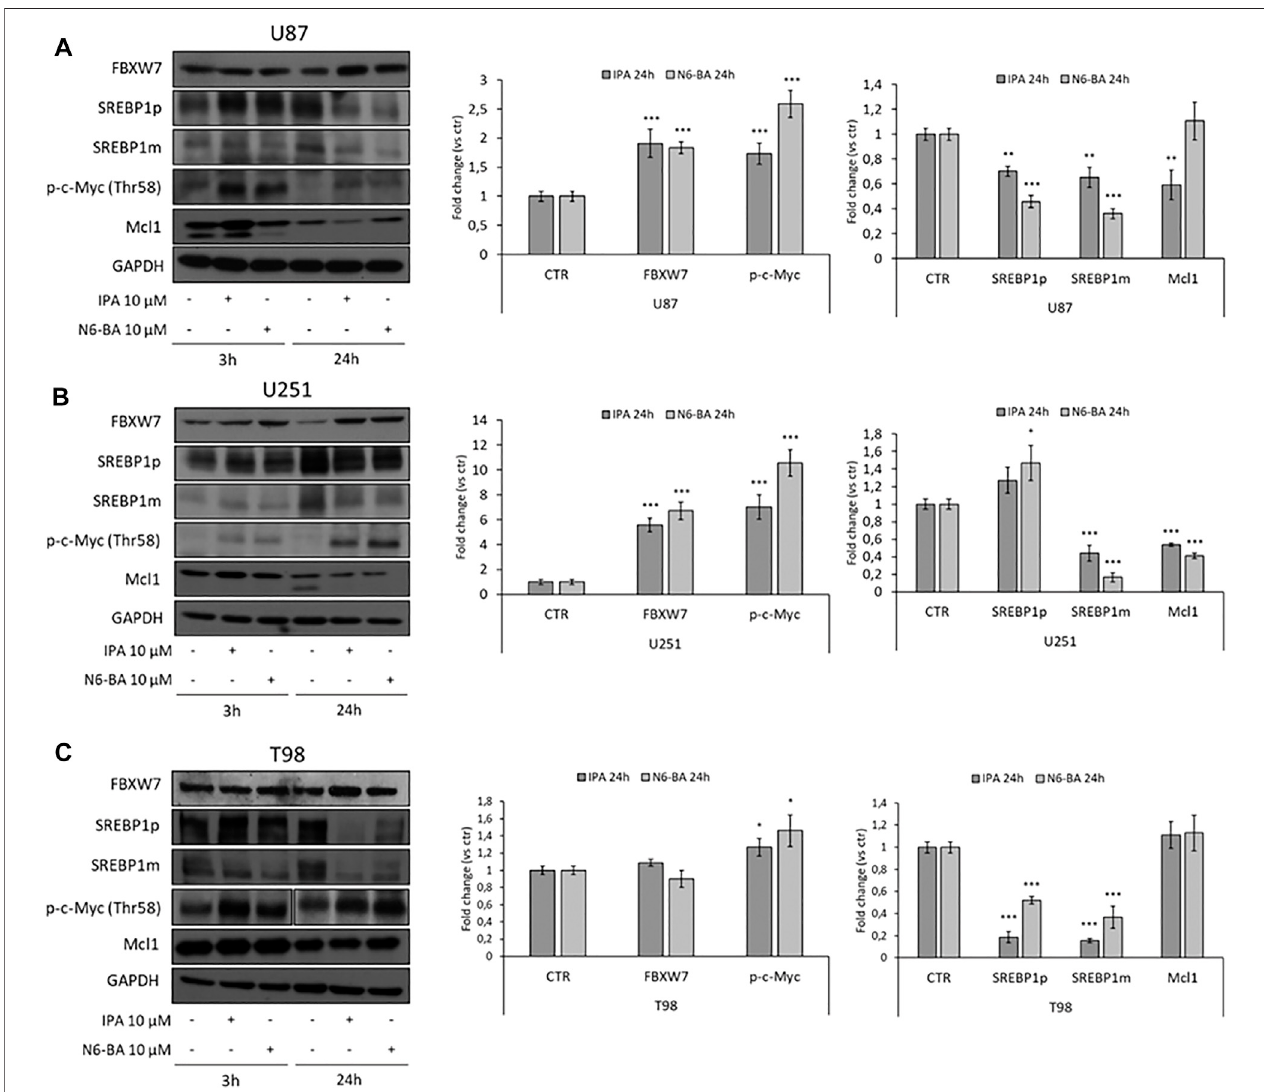
FIGURE 1 | IPA and N6-BA effect on FBXW7 modulation in GBM cells. Representative western blot of FBXW7, SREBP1 precursor (SREBP1p) and mature form (SREBP1m), phosphorylated c-Myc (Thr58) and Mcl1 protein expression in U87 (A) , U251 (B), and T98 (C) cells treated for 3 and 24 h with IPA or N6-BA. The histograms on the right represent the relative densitometric analysis at 24 h. GAPDH was used as a loading control. Data are expressed as mean ± SD of at least three independent experiments. * p < 0.05, ** p < 0.01, and *** p < 0.005 vs. control.